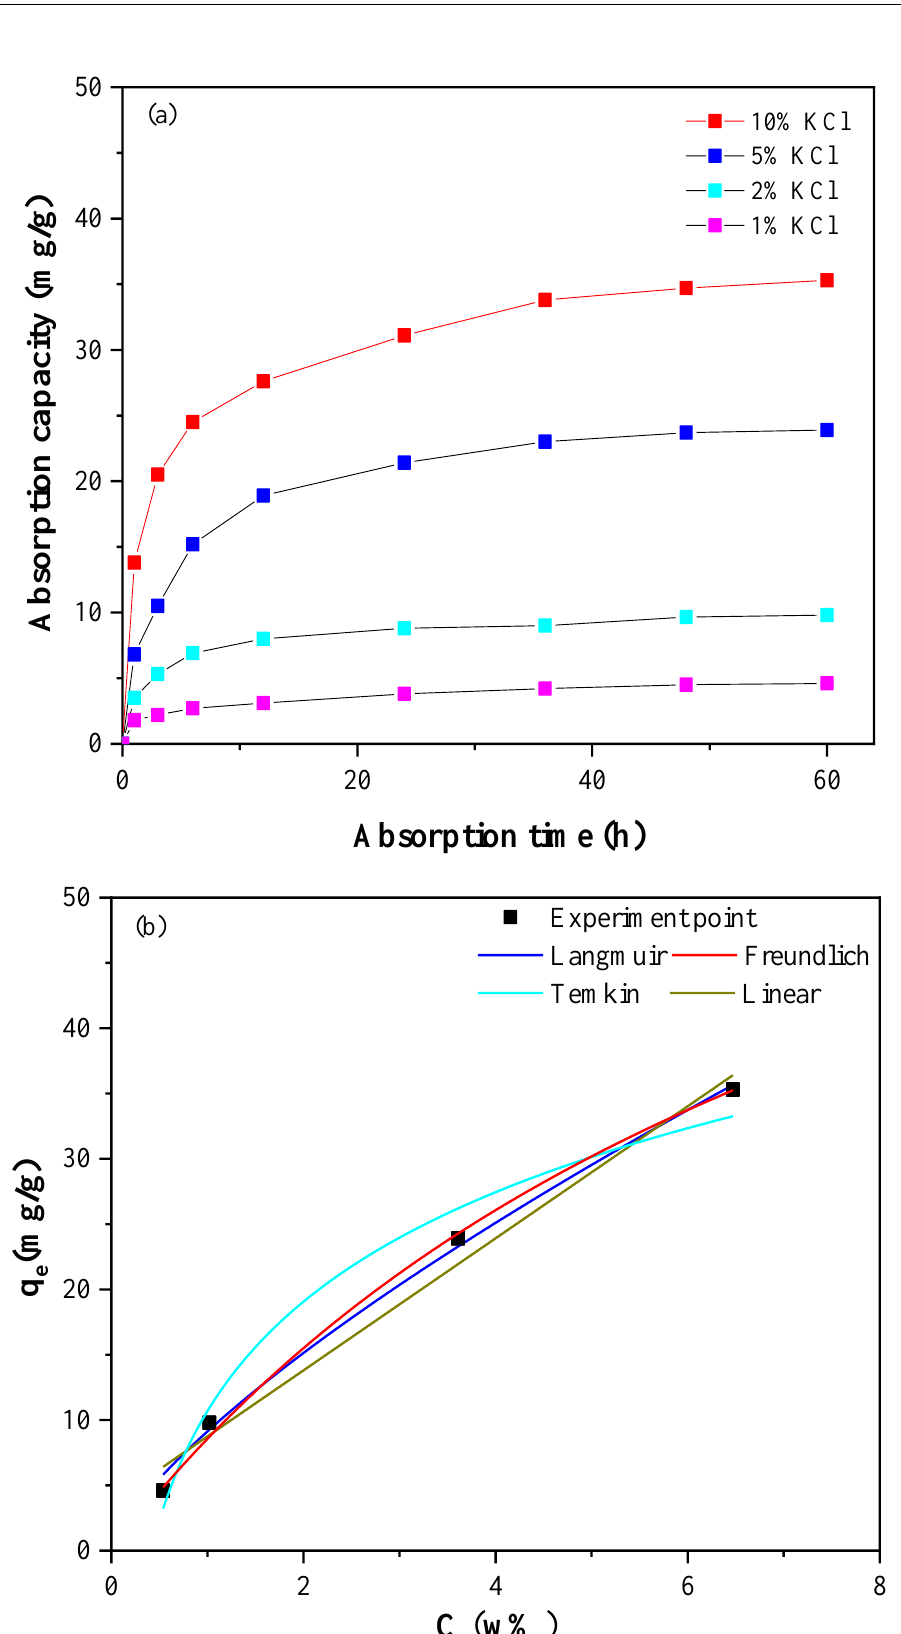
Figure 12. Adsorption curves of KCl: ( a ) absorption capacity over time and ( b ) adsorption isotherm.